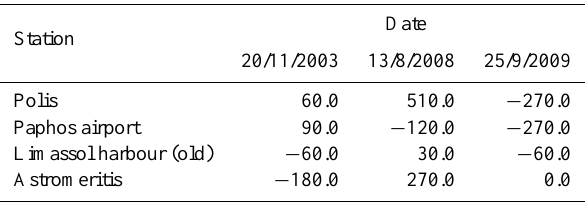
Table 4. Water losses (tonnes per month) for 1 hectare (Kokkinochoria